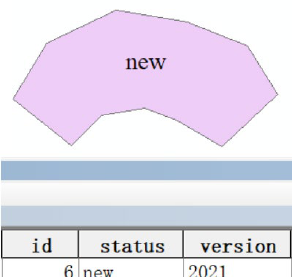
Figure 2 . Database fields information of new features